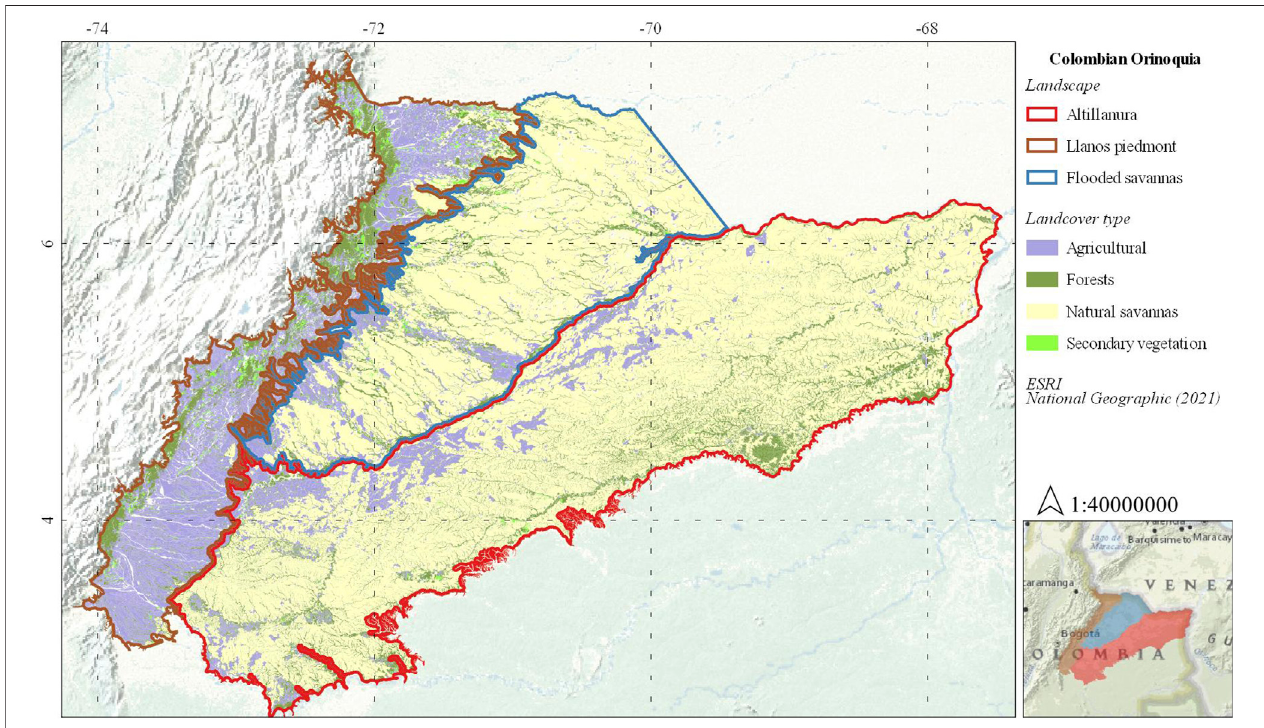
FIGURE 1 | Study area. Colombian Orinoquia landscapes. Modi fi ed from (Romero Ruíz et al., 2004; IDEAM, 2017).